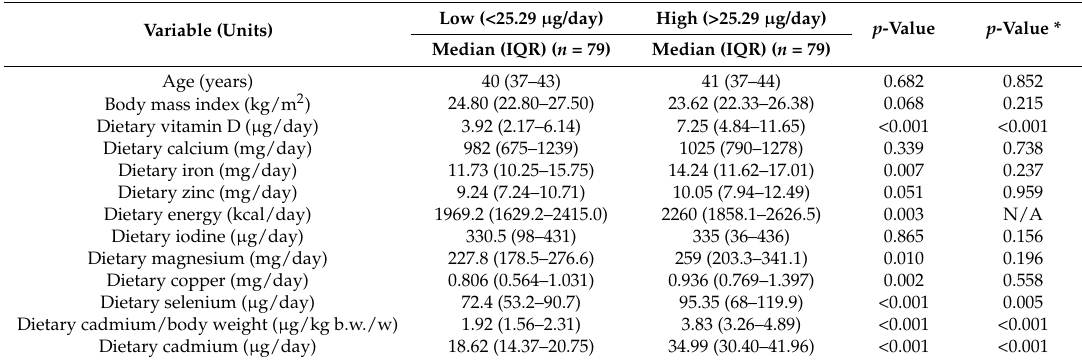
Table 1. Sample characteristics regarding cadmium dietary intake in premenopausal women. Variable